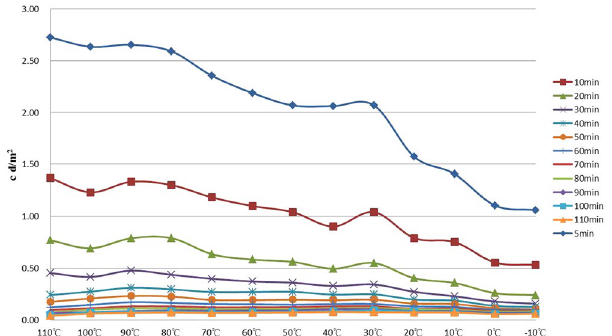
Figure 1. A TL-temperature plot for tests at a range of constant temperatures. The right hand side shows symbols for various durations, and the bottom scale indicates the constant temperatures used throughout the tests.